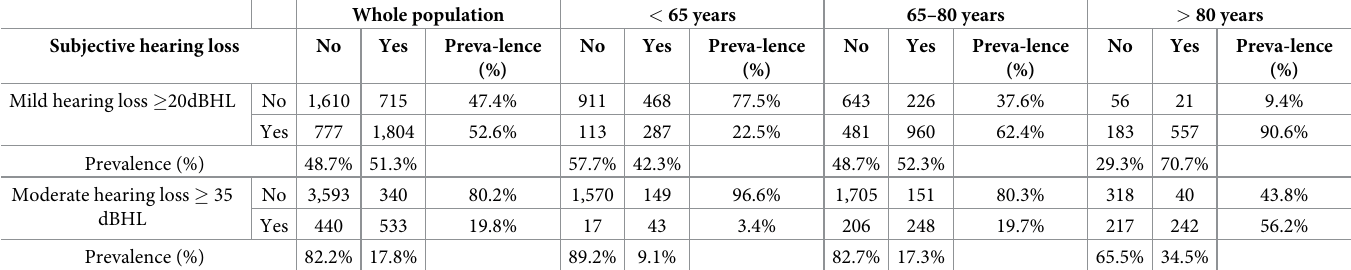
Table 3. Crosstab for the dichotomized answers to the question ‘Do you have any difficulty with your hearing?’. For defining mild hearing loss, all positive answers were included. For moderate hearing loss, “regularly” and “often” were the answer options included. These subjective measures were compared to the objective PTA 0.5–4 , mild: � 20dBHL, and moderate: � 35dBHL. Number of participants are depicted in each